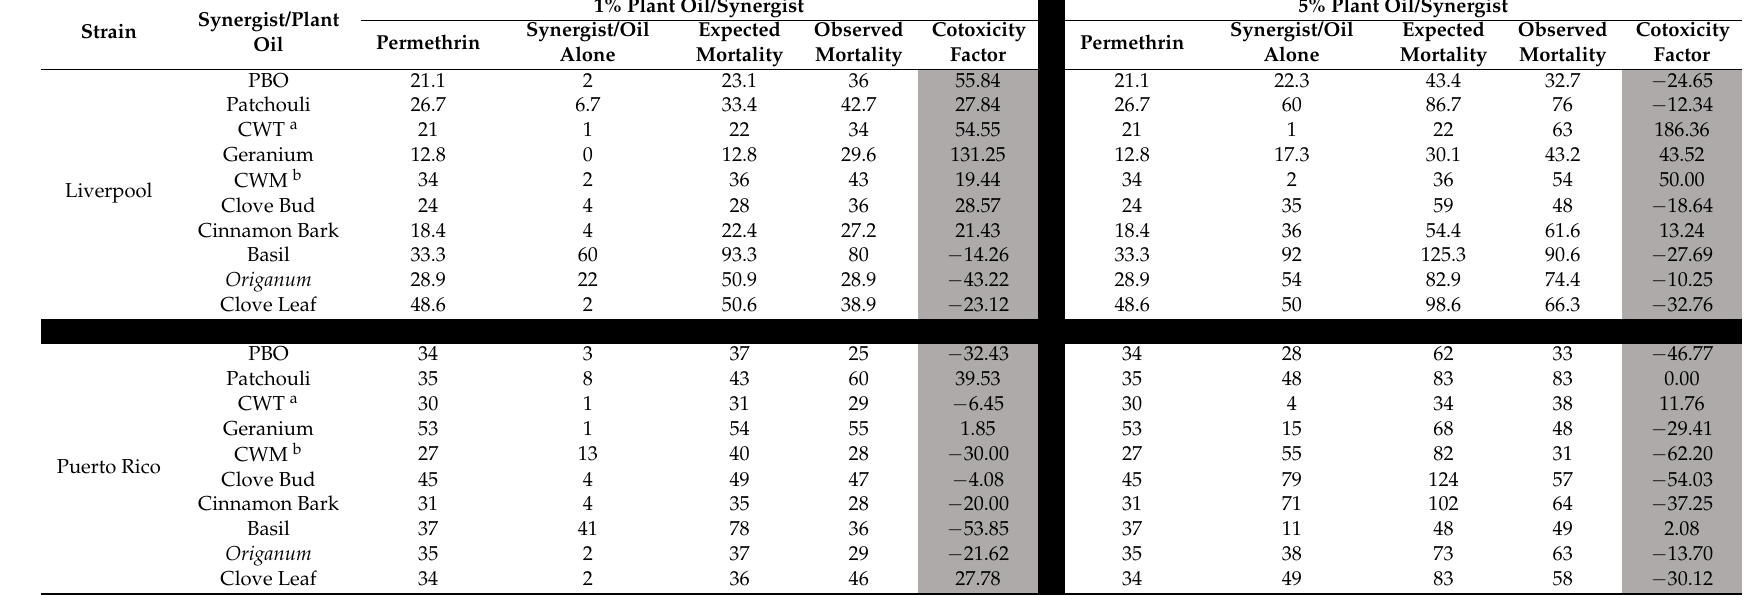
Table 2. Synergism caused by plant essential oils in combination with permethrin against Ae. aegypti